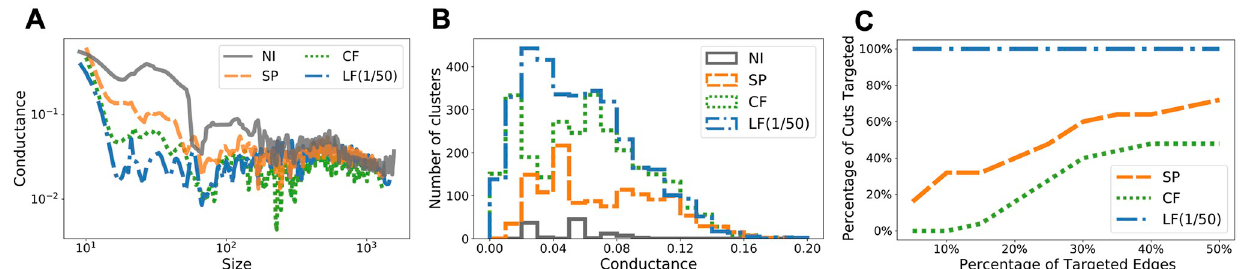
Fig 5. Characteristics of the modified Facebook County networks due to targeted interventions using different edge-betweenness measures. (A) NCPs (see Methods for a brief introduction). (B) Distribution of small-size clusters (having less than 100 nodes) by conductance. (C) Percentage of targeted out- link edges from the initial cluster of infection. Fig 5A and 5B show that the modified network due to LF intervention has many more well-defined (i.e., low conductance) small clusters, which can be effective at slowing down or stopping the spread of disease among tightly-knit small communities. For example, Fig 5C shows that only the top 5% edges based on LF betweenness already include all the out-link edges from the initial cluster of infection in Fig 3A.